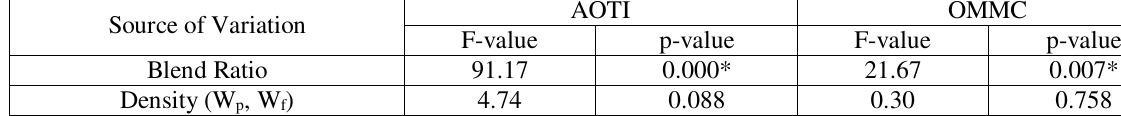
Table 5: Two-Way Anova Analysis of AOTI And OMMC